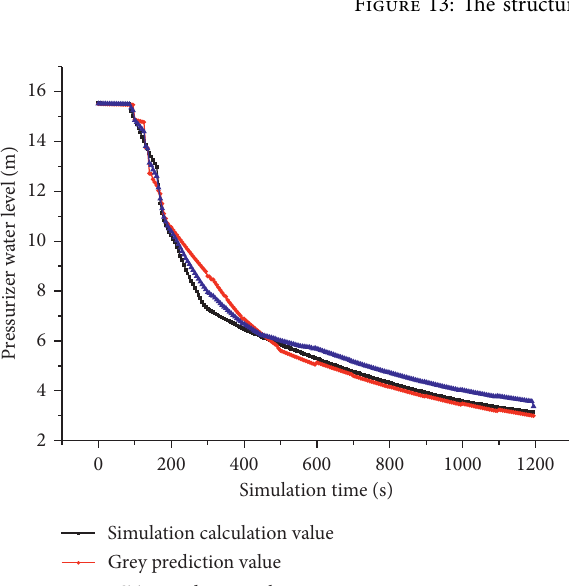
Figure 13: The structure of the LSTM neural network.